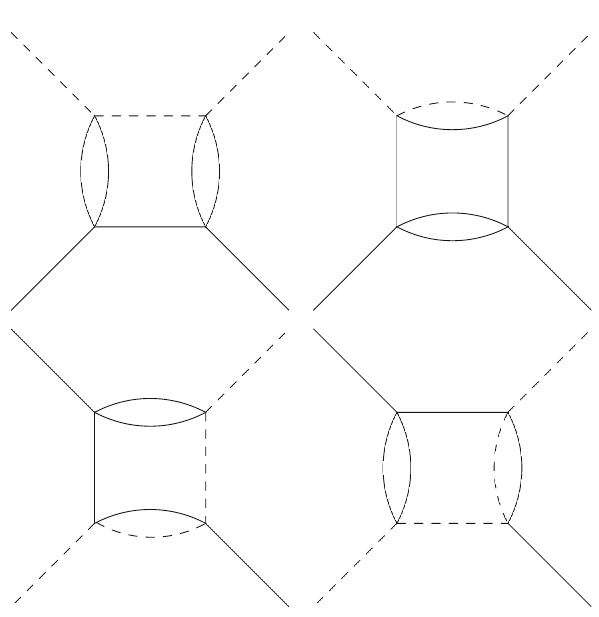
Fig. 19 Box diagrams for π K scattering. Continuous lines denote pions while dashed lines denote